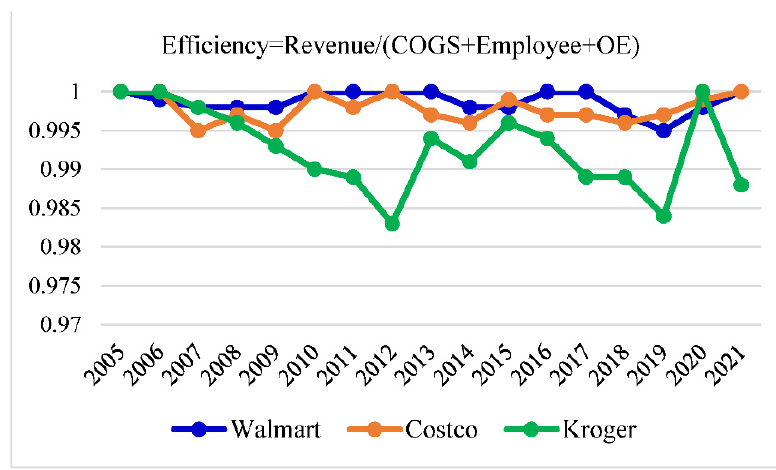
Figure 6. Operational efficiencies.